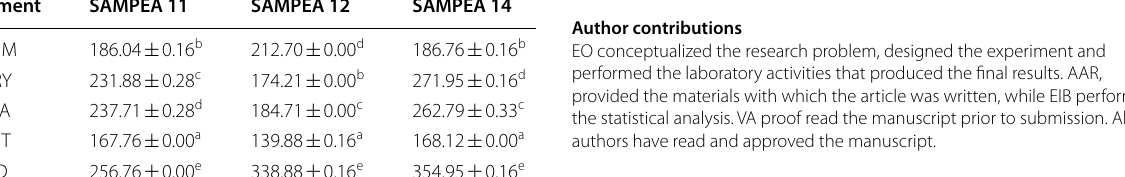
Table 1 Electrical conductivity of treated cowpea seed treated with botanical insecticides Electrical conductivity (µs/cm/g of seed)